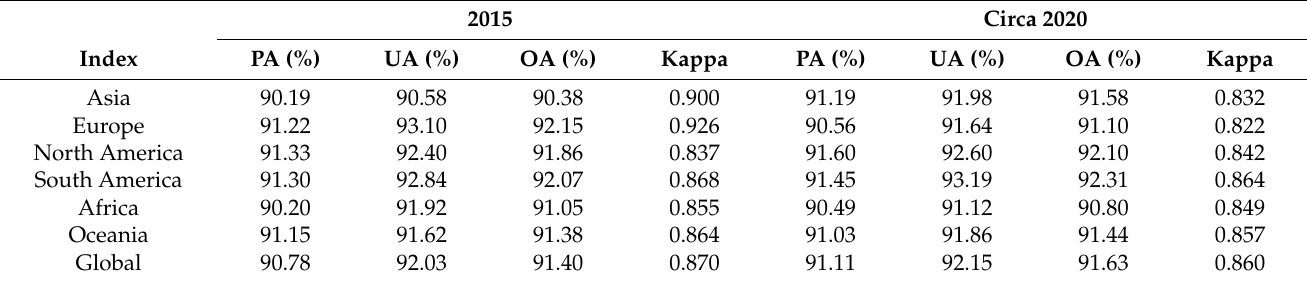
Table 2. The accuracy of urban boundaries acquired from Landsat images in 2015 and circa 2020.